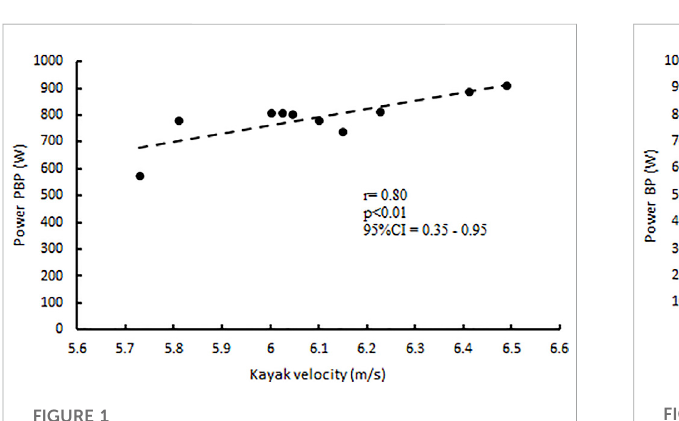
FIGURE 1 Correlation between P max (W) expressed at PBP, and kayak velocity (m/s) reached on KTS.